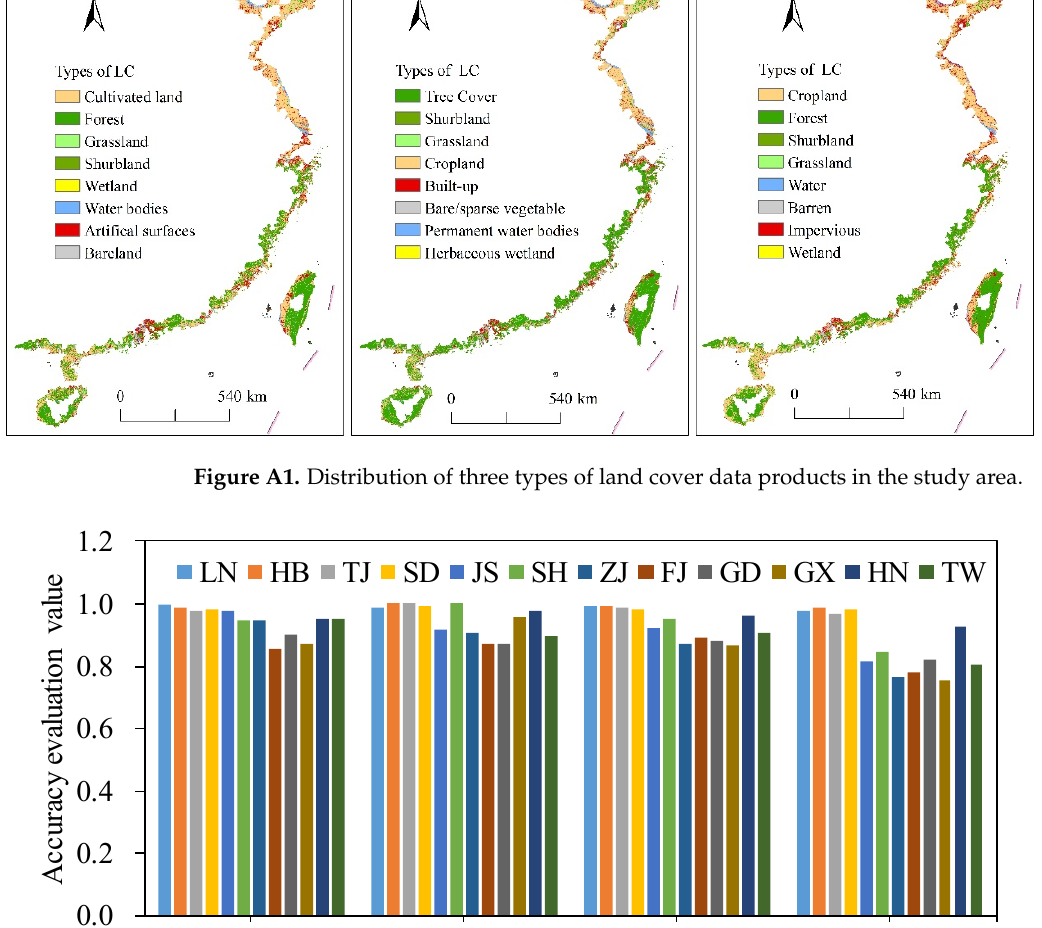
Figure A2. Extraction accuracy of aquaculture ponds in different provinces